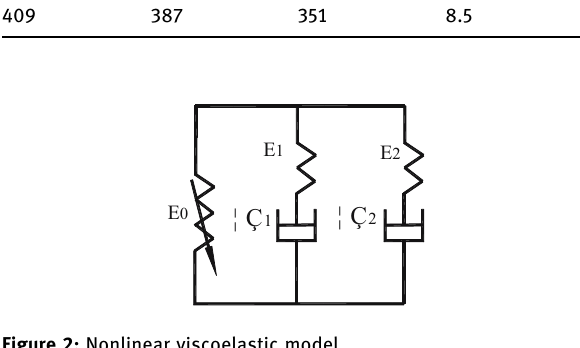
Figure 2: Nonlinear viscoelastic model.